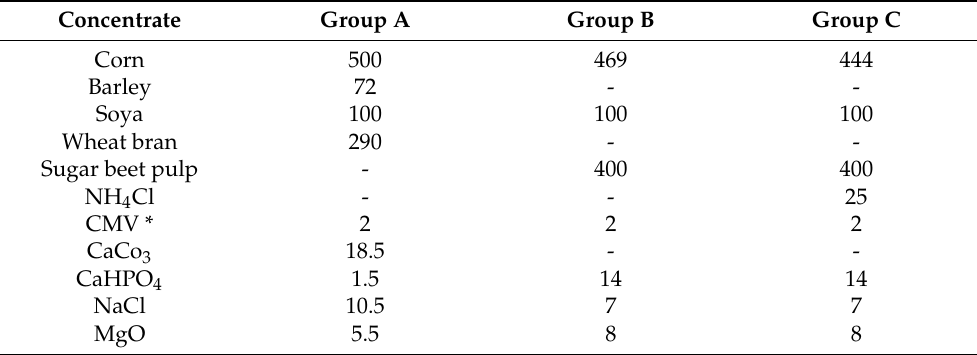
Table 1. Composition of concentrate pellet mixture determined for every 1000 kg of food of each experimental group. Concentrate Group A Group B Group C Corn 500 469 444 Barley 72 - - Soya 100 100 100 Wheat bran 290 - - Sugar beet pulp - 400 400 NH 4 Cl - CMV * CaCo 3 CaHPO 4 NaCl